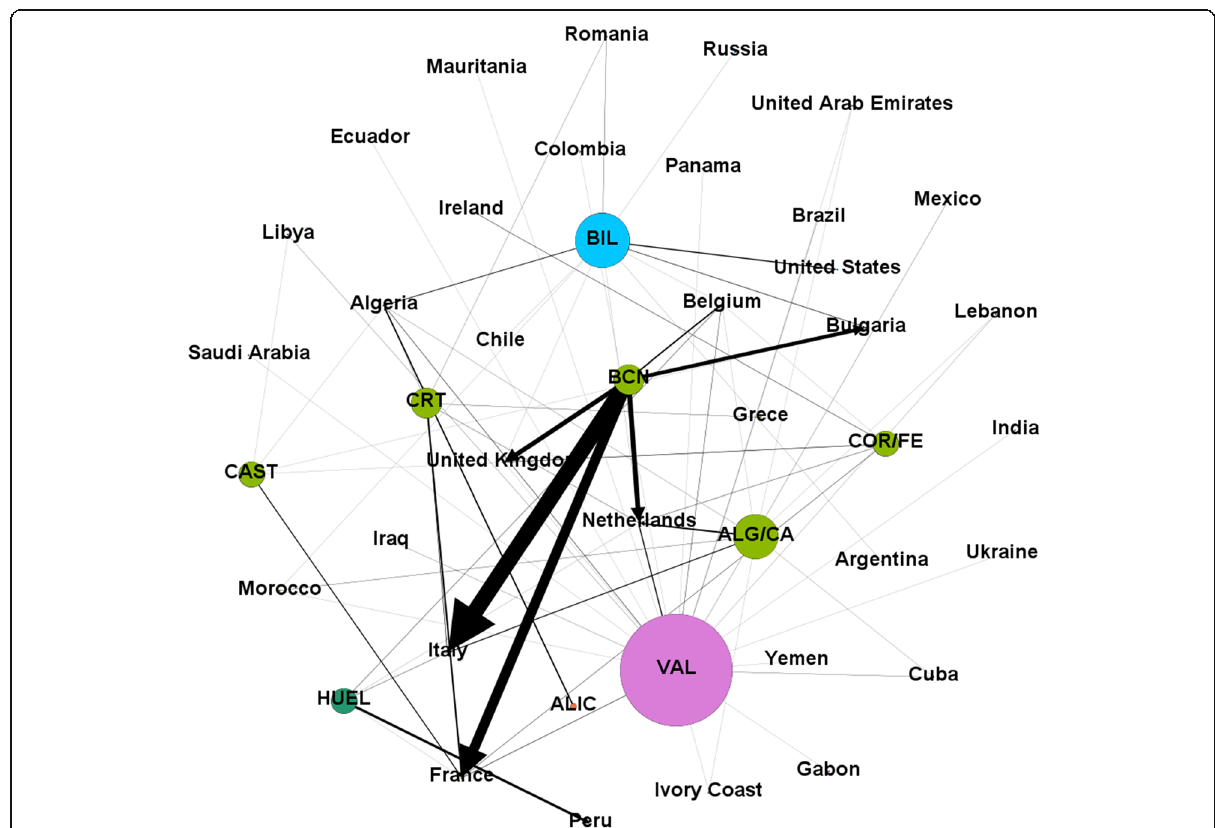
Fig. 3 Main export links for biofuels in 2019. Nodes and arrows are proportional to the degree of the node and the weight of the link respectively. Nodes in the same community are represented with the same color